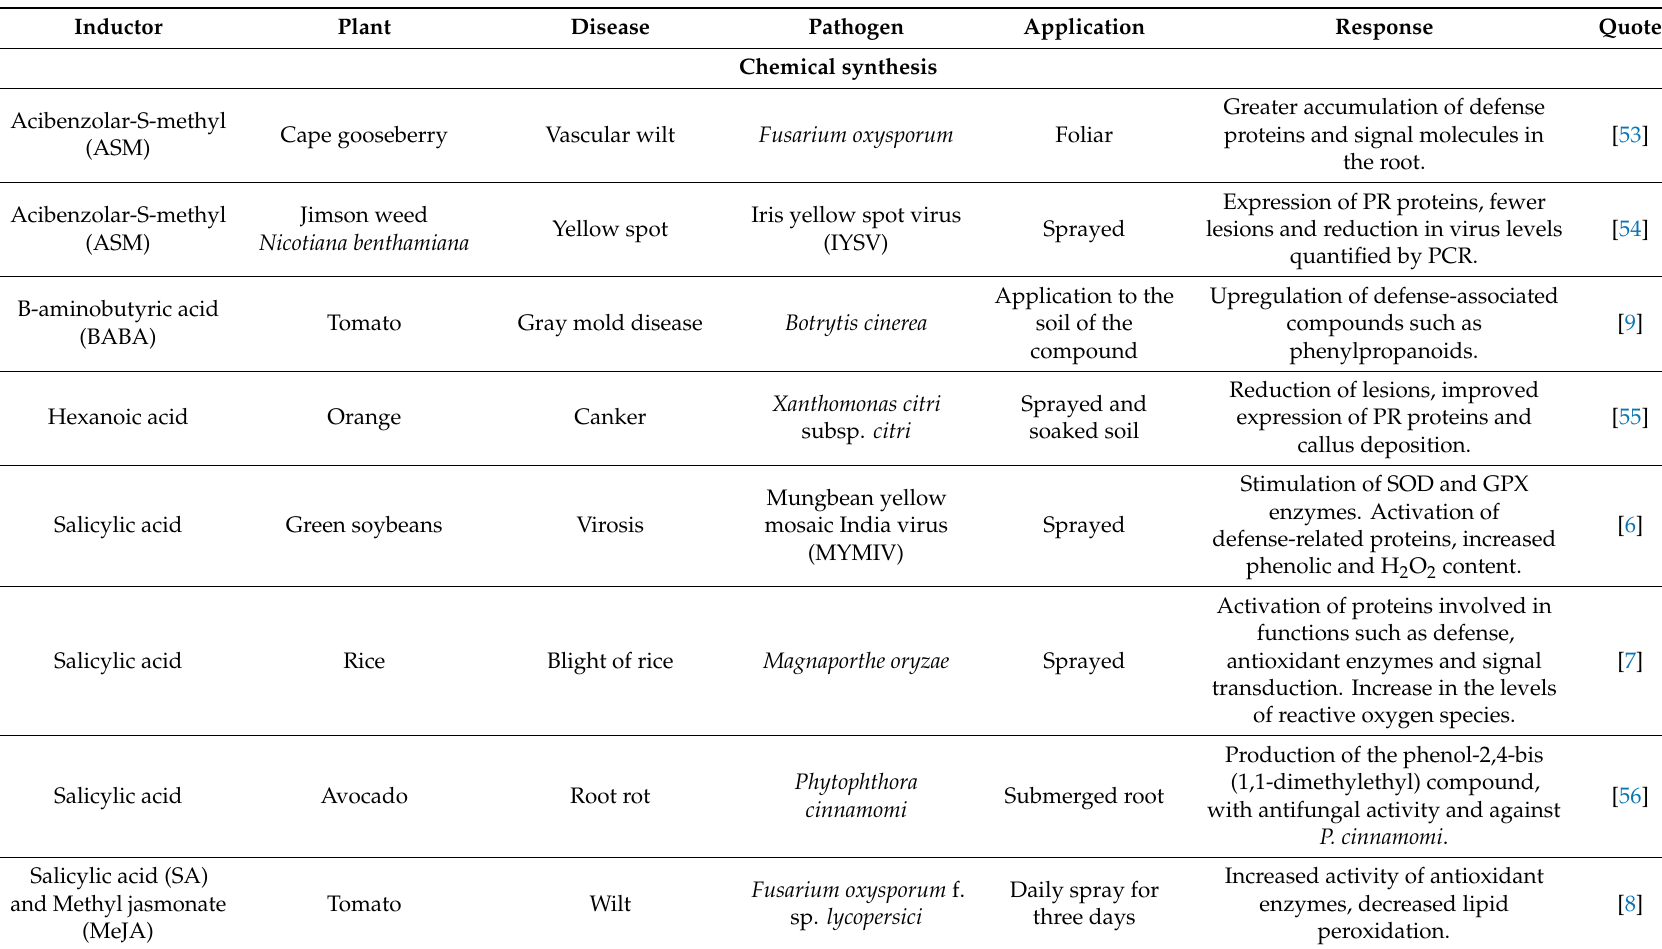
Table 1. Inductors of chemical synthesis and oligosaccharides that generate resistance in di ff erent cultures against their respective